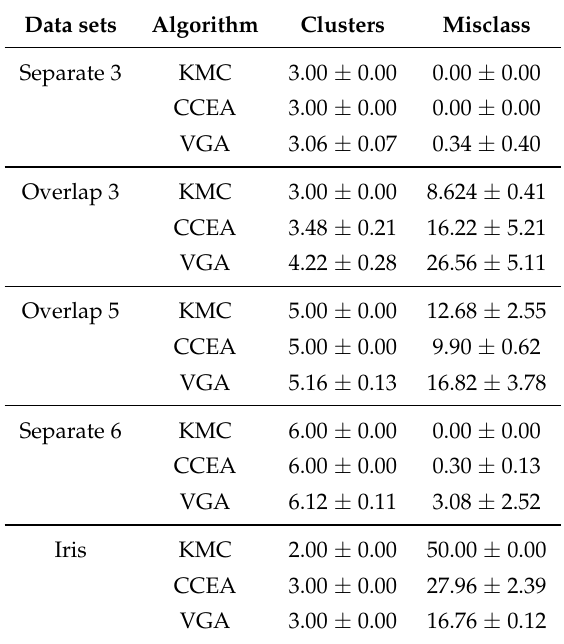
Table 4. Performance of FCM, VGA and CCEA.